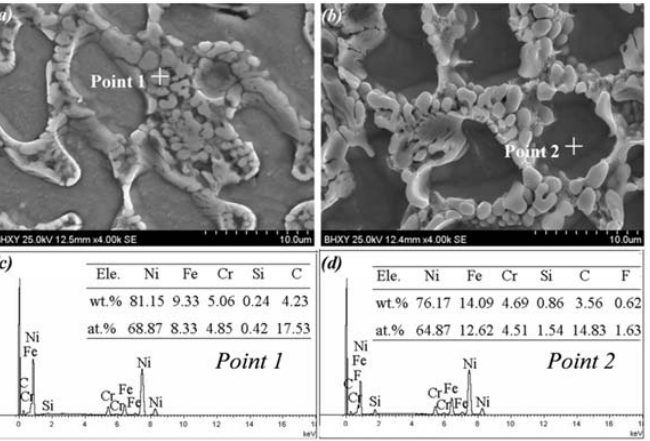
7 of 12 Figure 6. SEM morphologies of the Ni35 coatings fabricated at 5 kW, 200 mm/min: ( a ) various dendrite morphologies, ( b ) flower ‐ like morphology, ( c ) pearl ‐ like morphology, ( d ) fishbone ‐ like morphology, ( e ) column ‐ like morphology, and ( f ) schematic illustration of the sectioning effect. As shown in Figure 5a–c, the fraction of flower ‐ like dendrites increased gradually with the decrease in Vs, which reflected the growth direction evolution. With the high Vs of 300 mm/min, the melted depth D was low, as mentioned above. The bottom region of the molten pool solidified rapidly due to the low D and high Vs, which facilitated the heat dissipation from the molten pool to the beneath substrate [32]. As a result, dendrites with a vertical growth direction were dominant [33], which displayed fishbone ‐ like or column ‐ like morphologies on the cross ‐ section. With the decrease in Vs, heat flow turned to the molten pool tail. As a result, the dendrite growth direction became perpendicular